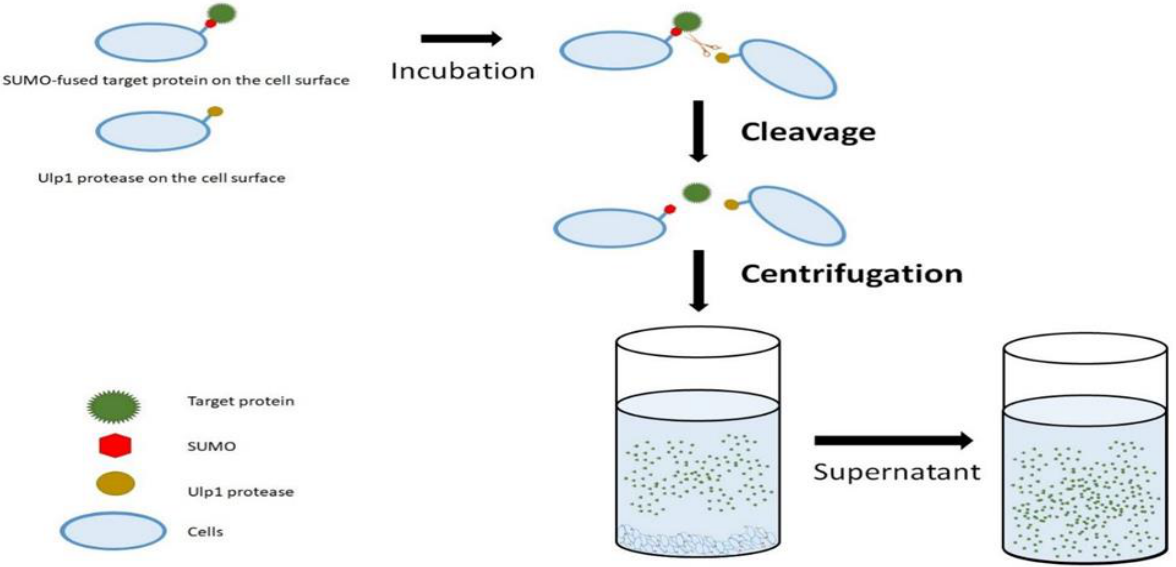
using the SUMO–Ulp1 Figure 5. The diagram shows the protein purification approach established on a cell-surface display using the SUMO – Ulp1 system.